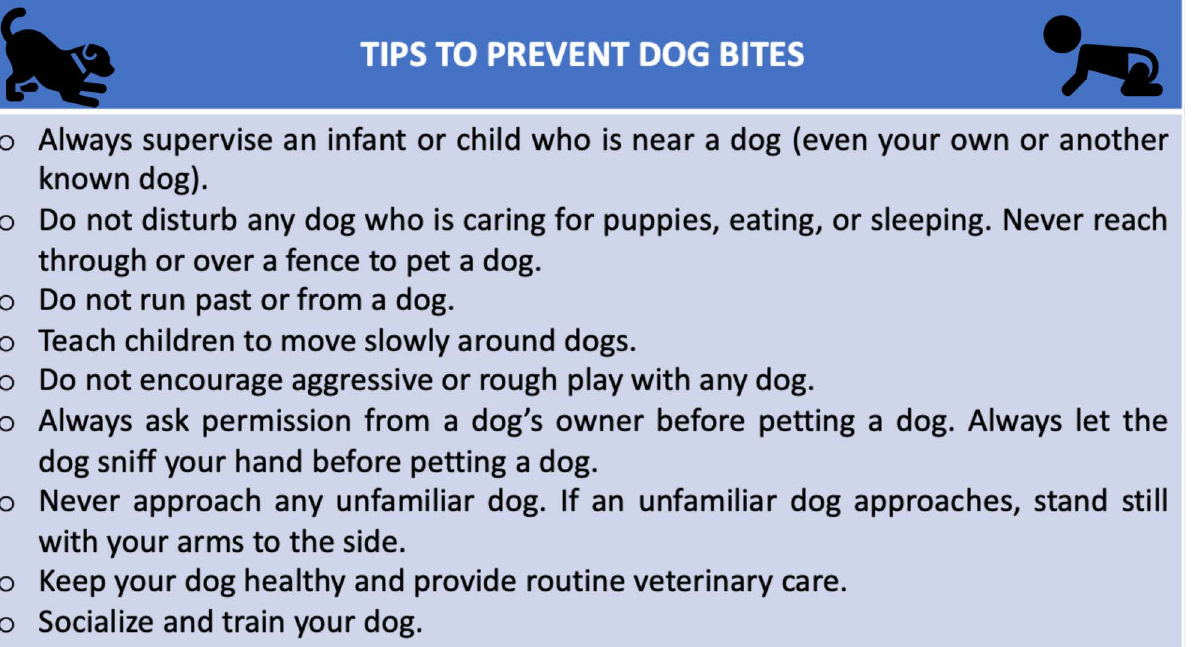
Figure 4. Tips to prevent dog